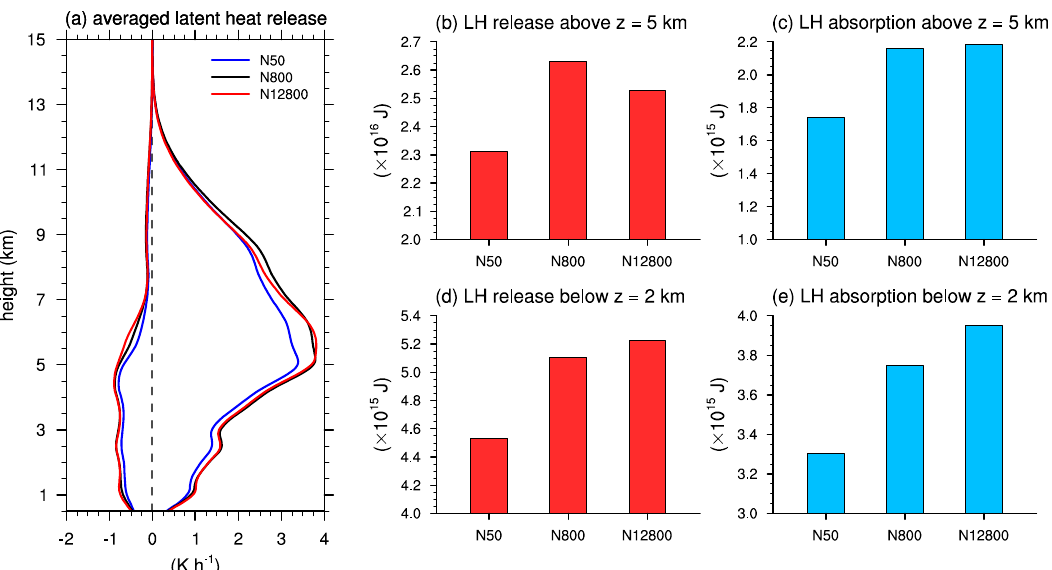
Figure 16. ( a ) Vertical profiles of latent heat release and absorption rates. The lines on the positive and the negative sides represent the latent heat release and absorption, respectively. The bar graphs show the accumulated ( b ) latent heat release amount and ( c ) latent heat absorption amount above z = 5 km in the N 0 = 50, 800, and 12,800 cm − 3 cases. Subfigures ( d , e ) are analogous to ( b , c ) but for below z = 2 km.